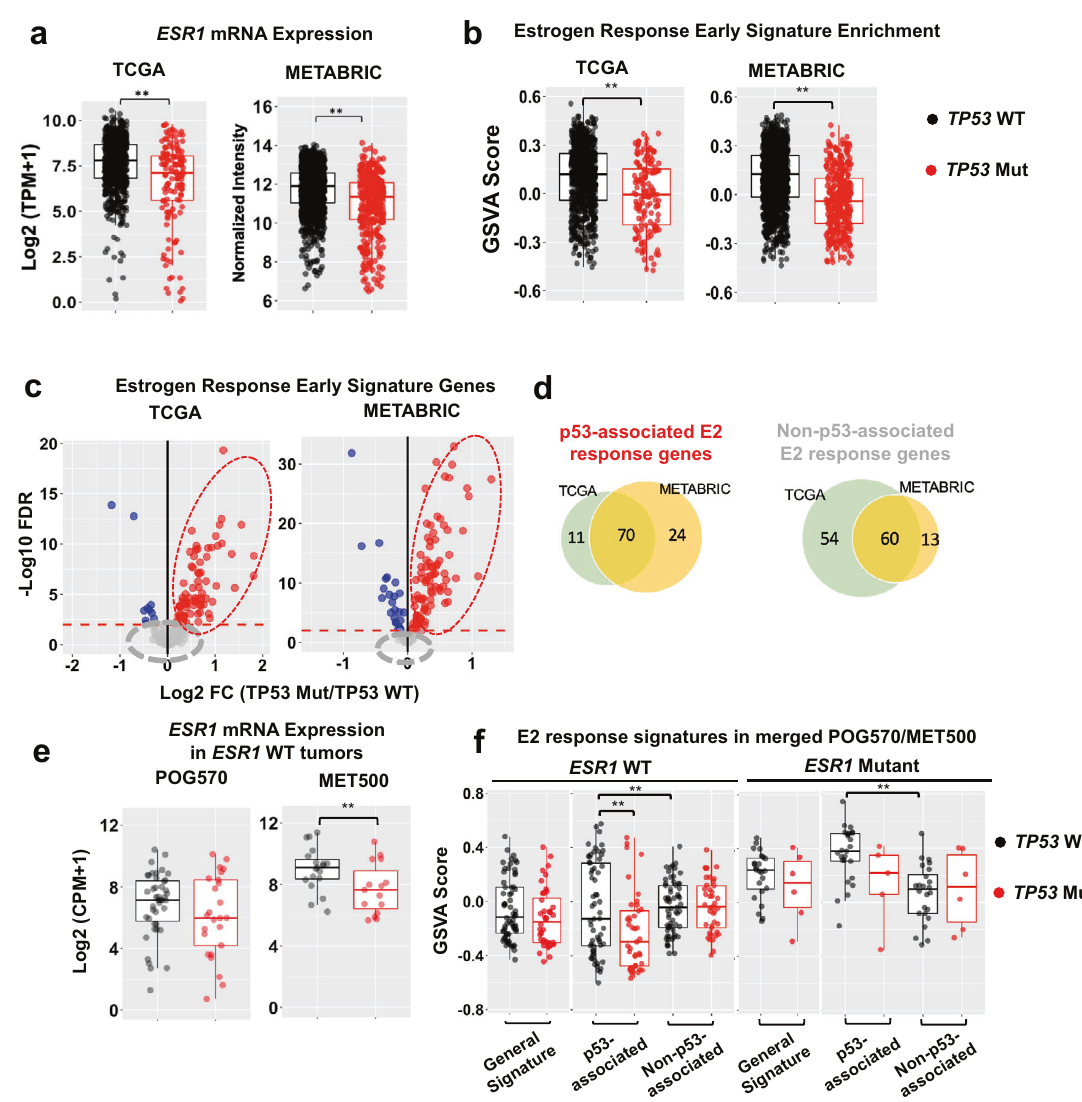
Fig. 3 TP53 mutation is inversely correlated with expression of ER- α and a subset of downstream genes. a , b Box plots representing the expression levels of ESR1 gene ( a ) or enrichment levels of “ Estrogen Response Early ” signatures ( b ) in TP53 WT versus TP53 mutant ER + primary tumors from TCGA ( n = 672 TP53 WT; n = 136 TP53 Mut) and METABRIC ( n = 1187 TP53 WT; n = 318 TP53 Mut) cohorts. Box plots span the upper quartile (upper limit), median (center), and lower quartile (lower limit). Whiskers extend a maximum of 1.5X IQR. Mann – Whitney U test (two-sided) was used (** p < 0.01). c Volcano plots showing differentially expressing genes within Estrogen Response Early signature ( n = 200) in TP53 mutant tumors versus WT tumors in TCGA and METABRIC breast cancer cohorts. DE genes were selected using the cutoff of FDR < 0.01. Genes that were upregulated, downregulated, or unchanged were labeled in red, blue, and gray respectively. d Venn diagram showing the overlap of mutant p53 positively associated (left panel) or unassociated (right panel) estrogen response genes between TCGA and METABRIC cohorts. The intersected 70 and 60 genes consist of the P53-ER Signature and Non-P53-ER Signature respectively. e Box plots representing the expression levels of ESR1 gene in TP53 WT ( n = 19 for MET500; n = 43 for POG570) versus TP53 mutant ( n = 15 for MET500; n = 25 for POG570) metastatic tumors in MET500 and POG570 cohorts. Box plots span the upper quartile (upper limit), median (center), and lower quartile (lower limit). Whiskers extend a maximum of 1.5× IQR. Samples were pre-selected for ESR1 WT genotype. Mann – Whitney U test (two-sided) was applied to each cohort (** p < 0.01). f Box plots representing the enrichment levels of general “ Estrogen Response Early ” signatures, P53-ER Signature, and Non-P53-ER Signature between TP53 WT and mutant tumors in the separate contexts of ESR1 WT (left panel, n = 62 TP53 WT; n = 40 TP53 Mut) and mutant (right panel, n = 24 TP53 WT; n = 6 TP53 Mut) tumors. GSVA scores were combined from MET500 and POG570 cohorts. Box plots span the upper quartile (upper limit), median (center), and lower quartile (lower limit). Whiskers extend a maximum of 1.5X IQR. Mann – Whitney U test (two-sided) was used for each comparison. (* p < 0.05; ** p < favorable predictive factor for endocrine therapy. In addition, previous clinical trials showed that chemo-endocrine combination as fi rst-line therapy improved outcomes, as exempli fi ed by aromatase inhibitors plus capecitabine for postmenopausal women 71 and tamoxifen plus CAF (cyclophosphamide, doxorubi- cin, and fl uorouracil) for premenopausal women 72 . Lastly, a recent